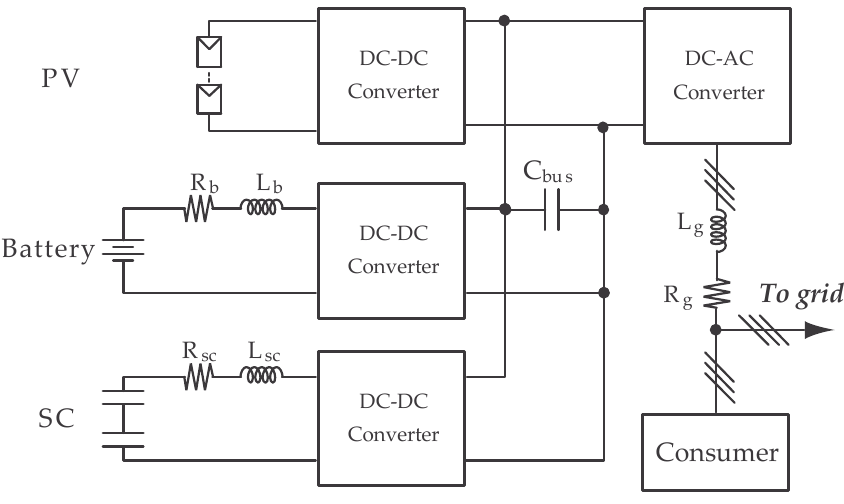
Figure 1. General structure of the HRES.